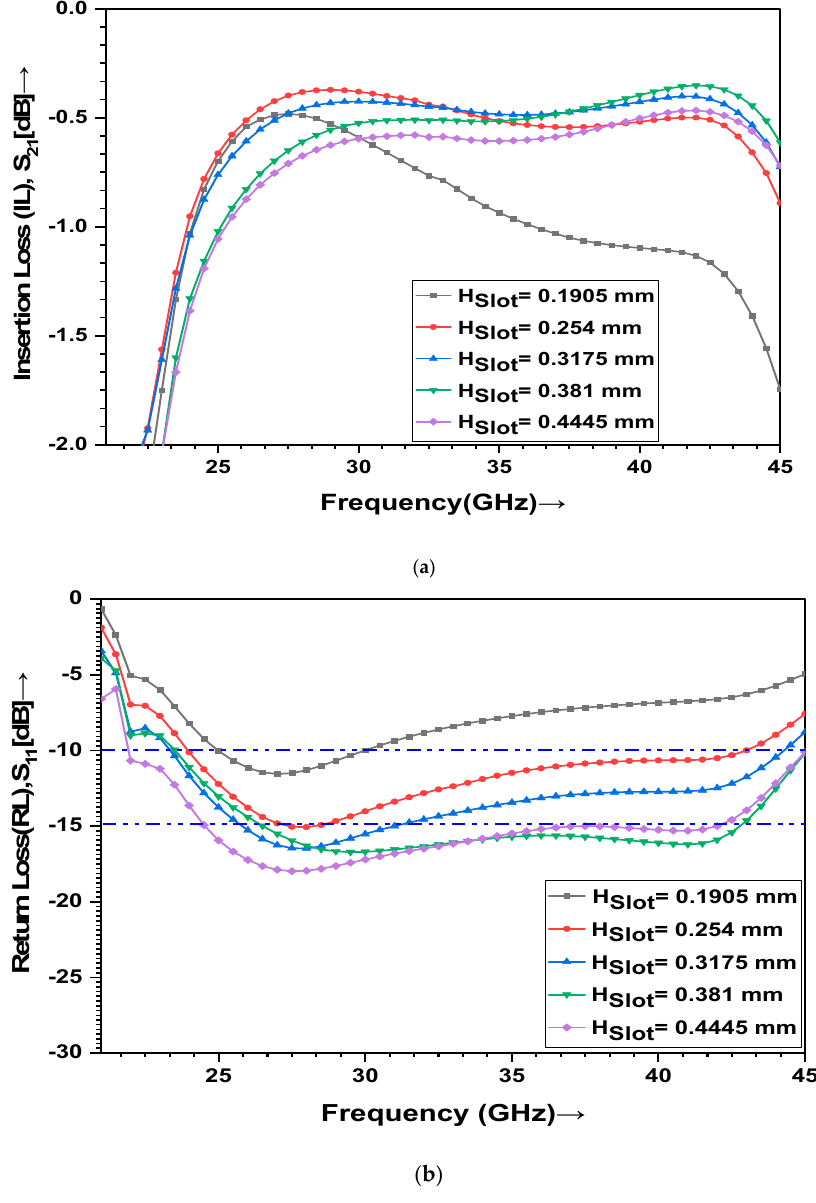
Figure 4. Effect of slot height variations on ( a ) IL and ( b ) RL.